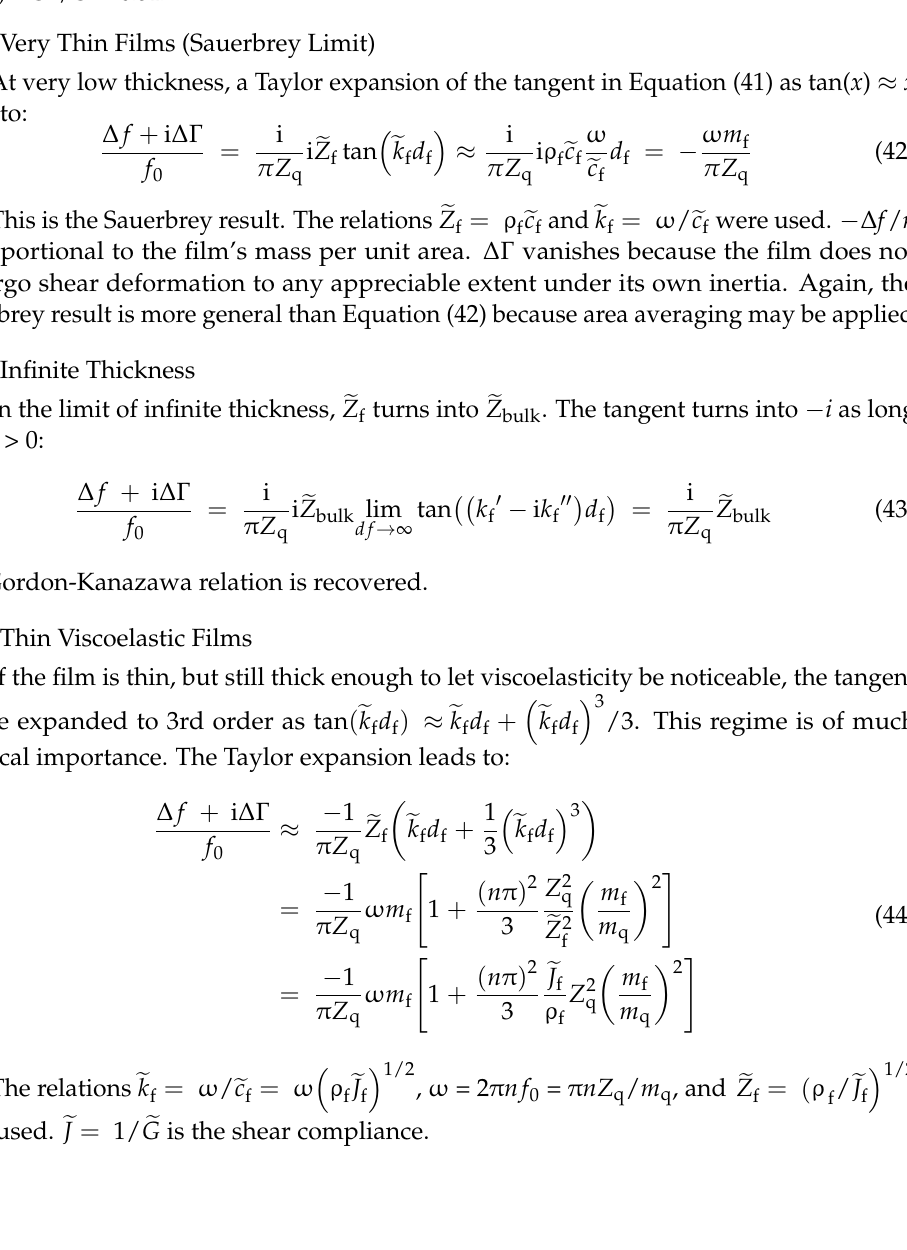
Figure 16. ∆ f and ∆Γ as a function of thickness, following Equation (41). The medium is assumed to be lossy, hence the broad film resonance. The loss tangent used in the calculation was tan( δ L ) = G ’’/ G ’ = 0.84.